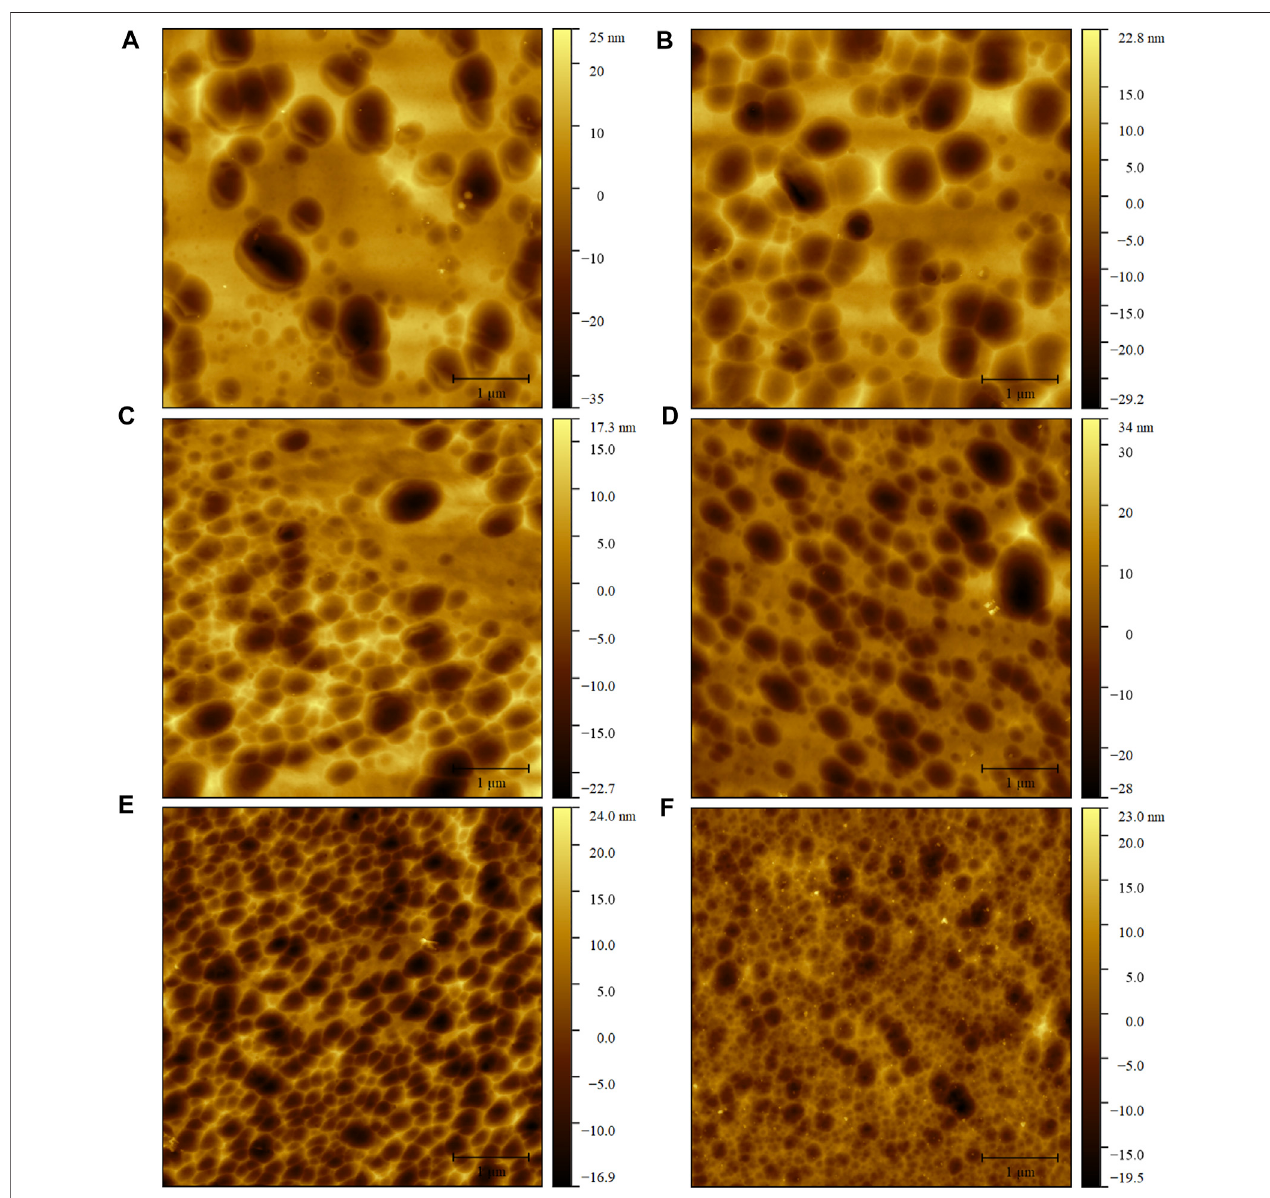
FIGURE 5 | Typical AFM topography images of coal samples. (A) sample WG-6, primary coal; (B) sample WG-4, cataclastic coal; (C) sample QYZ-70, schistose coal; (D) sampleRL-2, motarcoal; (E) sampleQD-3,granulitic coal; (F) sampleQYZ-86, fl akycoal;Thescanningrangeis5×5 μ mandthescanninglinesare512×512 in all images.